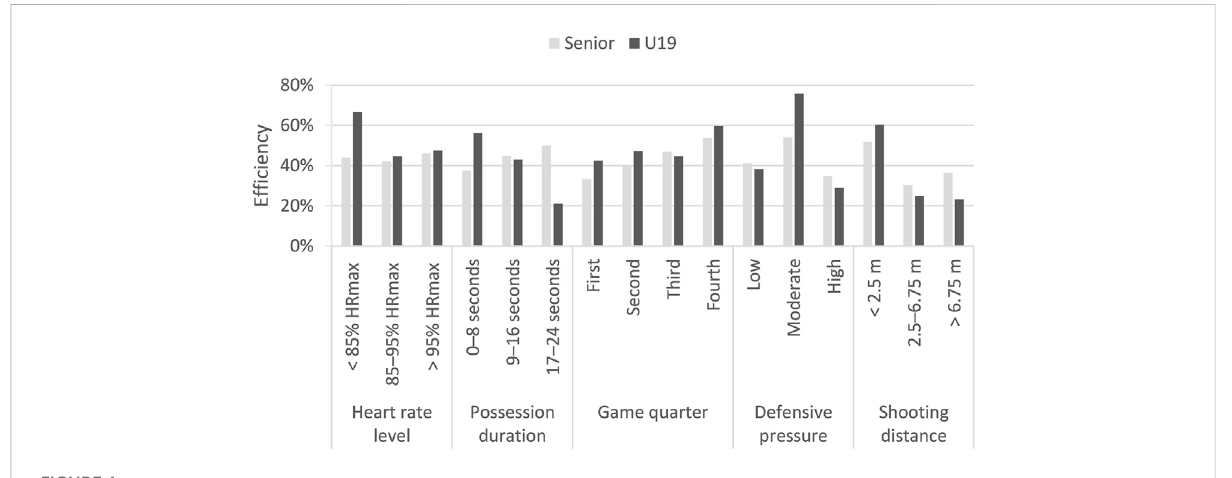
TABLE 5 Estimation of regression model parameters for shooting ef fi ciency with explanatory variables in the fourth step. Category Independent variables B SE. Wald df p OR 95% CI for OR U19 Low